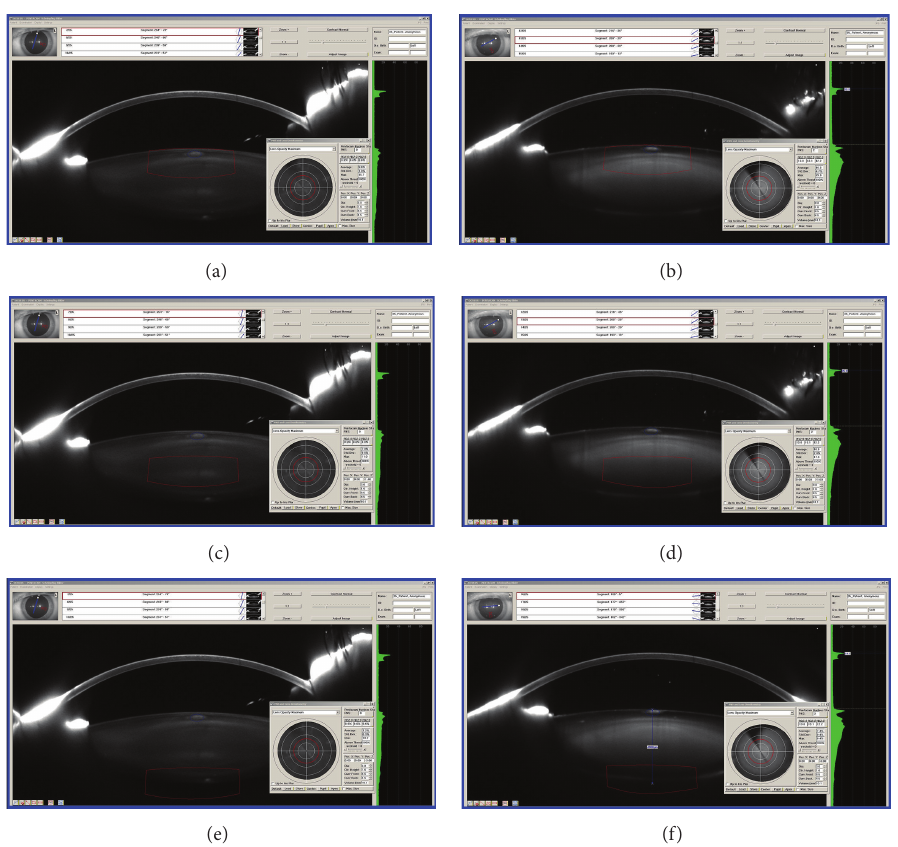
Figure 1: Patient sample of group 3. Three-dimensional lens densitometry before/after vitreoretinal surgery with preliminary silicone oil fill, measurements in three segments: upper line: pre-op. (left), anterior segment, post-op. (right); middle line: pre-op. (left), nucleus, post-op. (right); lower line: pre-op. (left), posterior segment, post-op. (right). Red cylinder: reference body for the three segments. Blue circle: light scattering artefact eliminated from densitometry